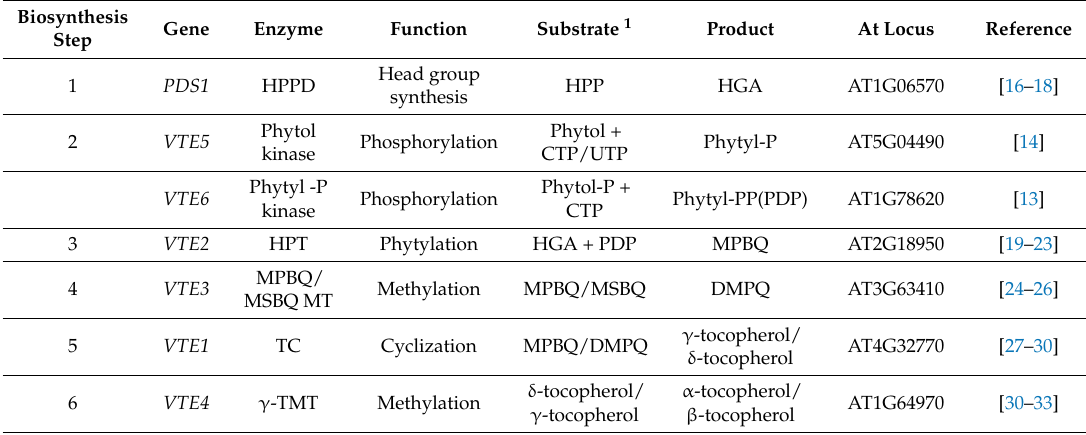
Table 1. Genes and enzymes of the tocopherol biosynthesis in A. thaliana